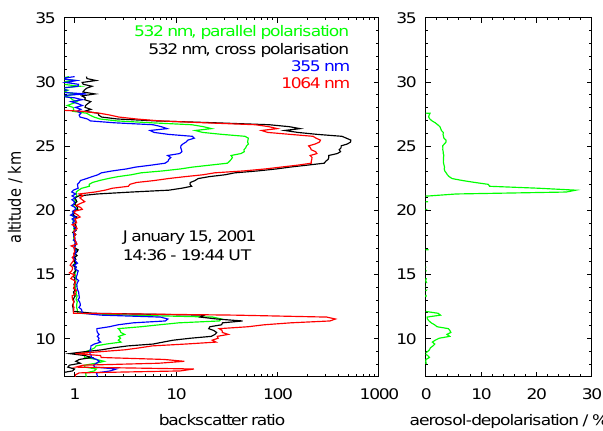
Fig. 6. Lidar observation of a polar stratospheric and a cirrus cloud on 15 January 2001. Shown are the backscatter ratio in the parallel and cross polarised channel at 532-nm wavelength, at 355nm, and at 1064nm (left), as well as the aerosol depolarisation